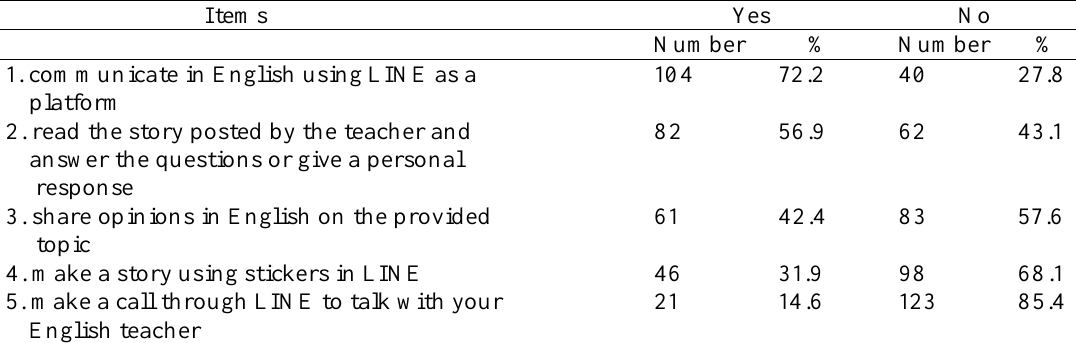
Frequency and Percentage of LINE-based Language